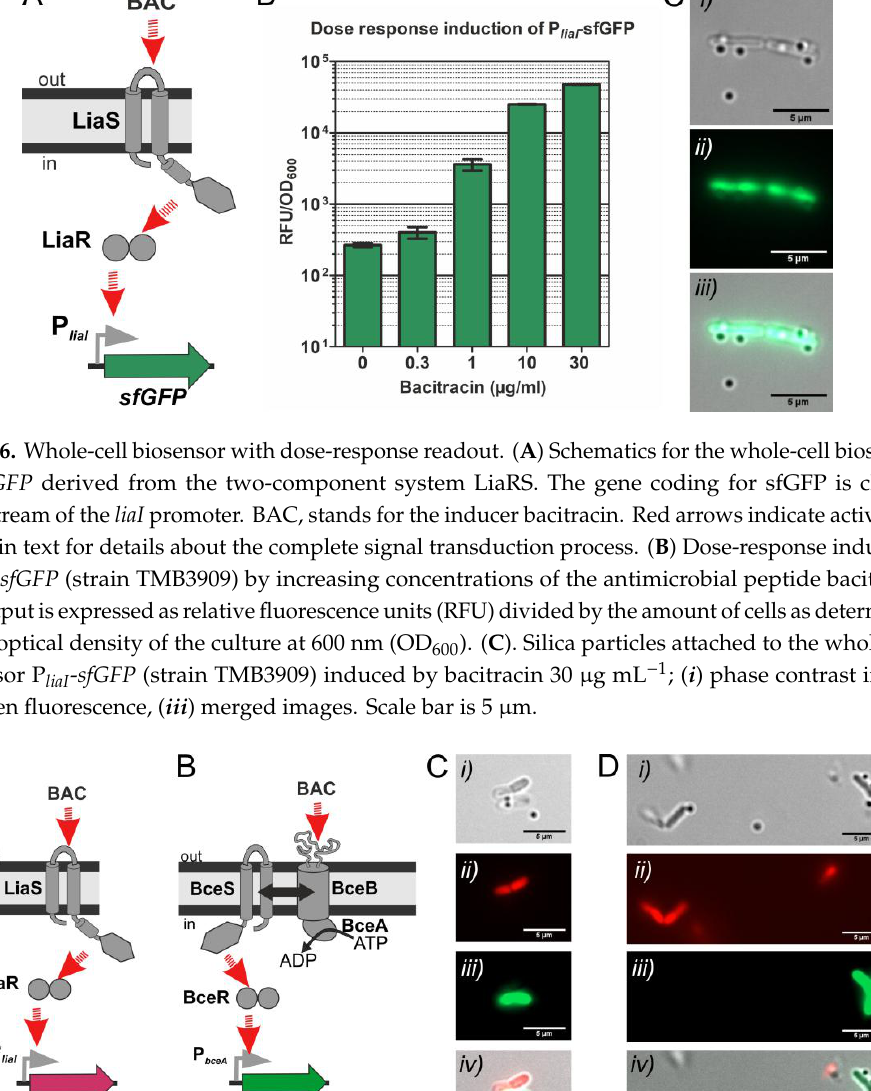
Figure 7. B. subtilis biosensors attached to abiotic particles and communicating the presence of bacitracin